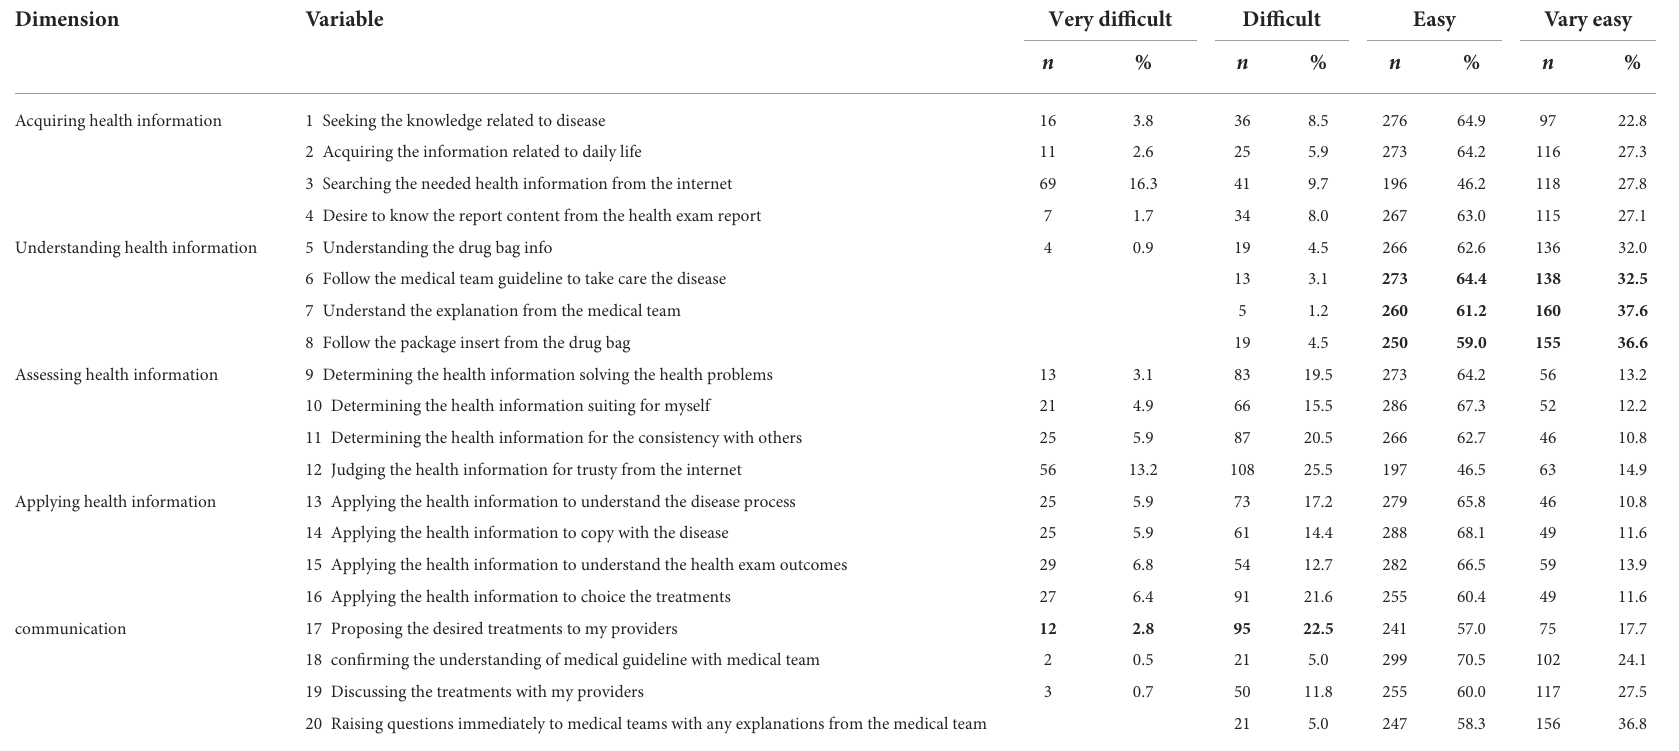
TABLE 2 The distribution of survey items and divided levels from health literacy in MMHLQ.